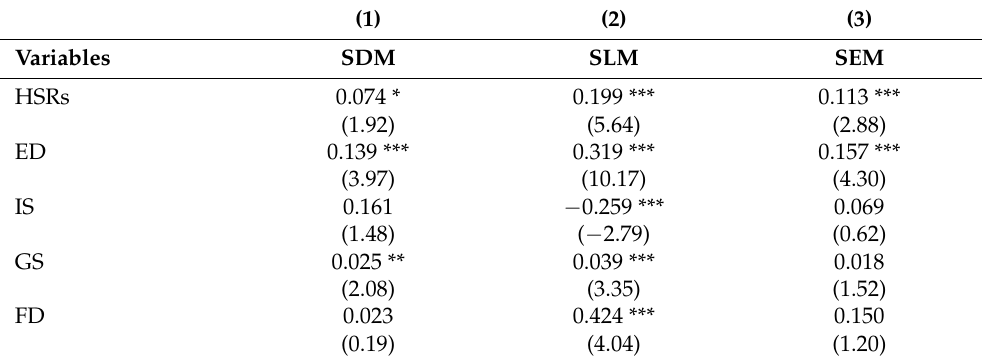
Figure 3. Scatter plots of the local Moran’s index of green patents in China’s cities in 2012.